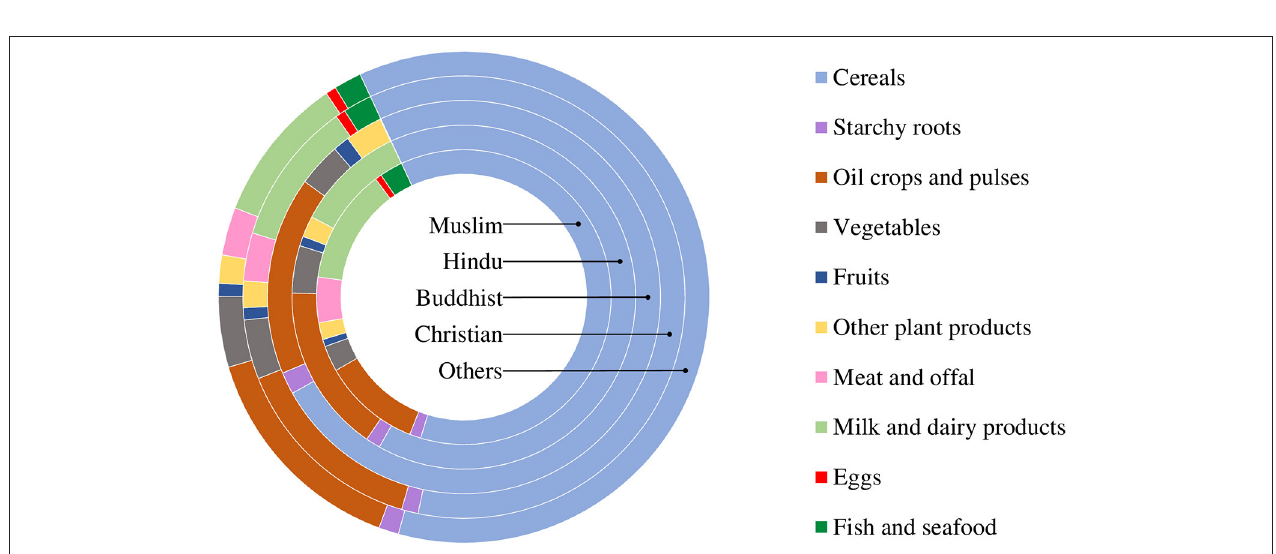
FIGURE 3 | Observed food N footprint of the countries in the ISC from the 1960s to the 2010s.